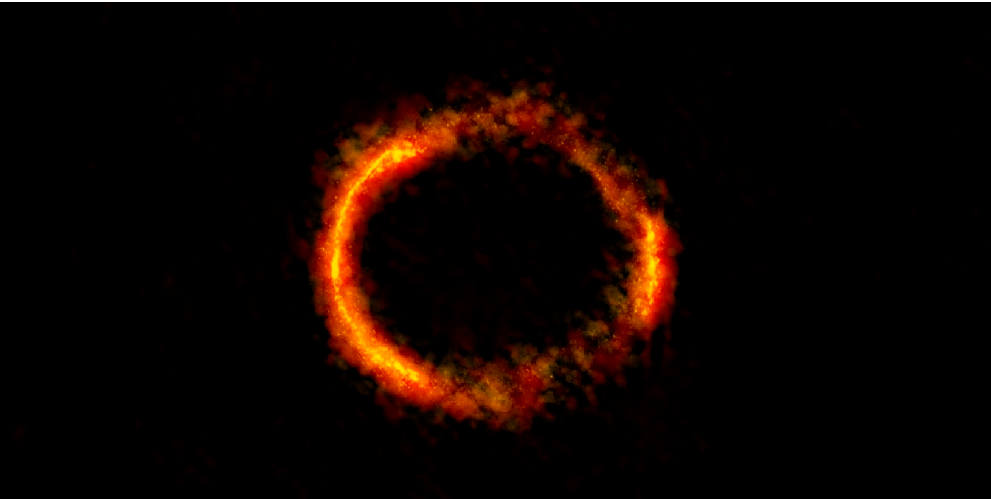
Figure 19. Gravitationally lensed galaxy SDP.81 taken by ALMA radiotelescope. The bright orange central region of the ring (ALMA’s highest-resolution observation ever, the emission tracing a radius of ~1.5”) reveals the glowing dust in this distant galaxy. The surrounding lower-resolution portions of the ring trace the millimetre-wavelength light emitted by carbon dioxide and water molecules. Credit: ALMA (NRAO/ESO/NAOJ); B. Saxton NRAO/AUI/NSF.